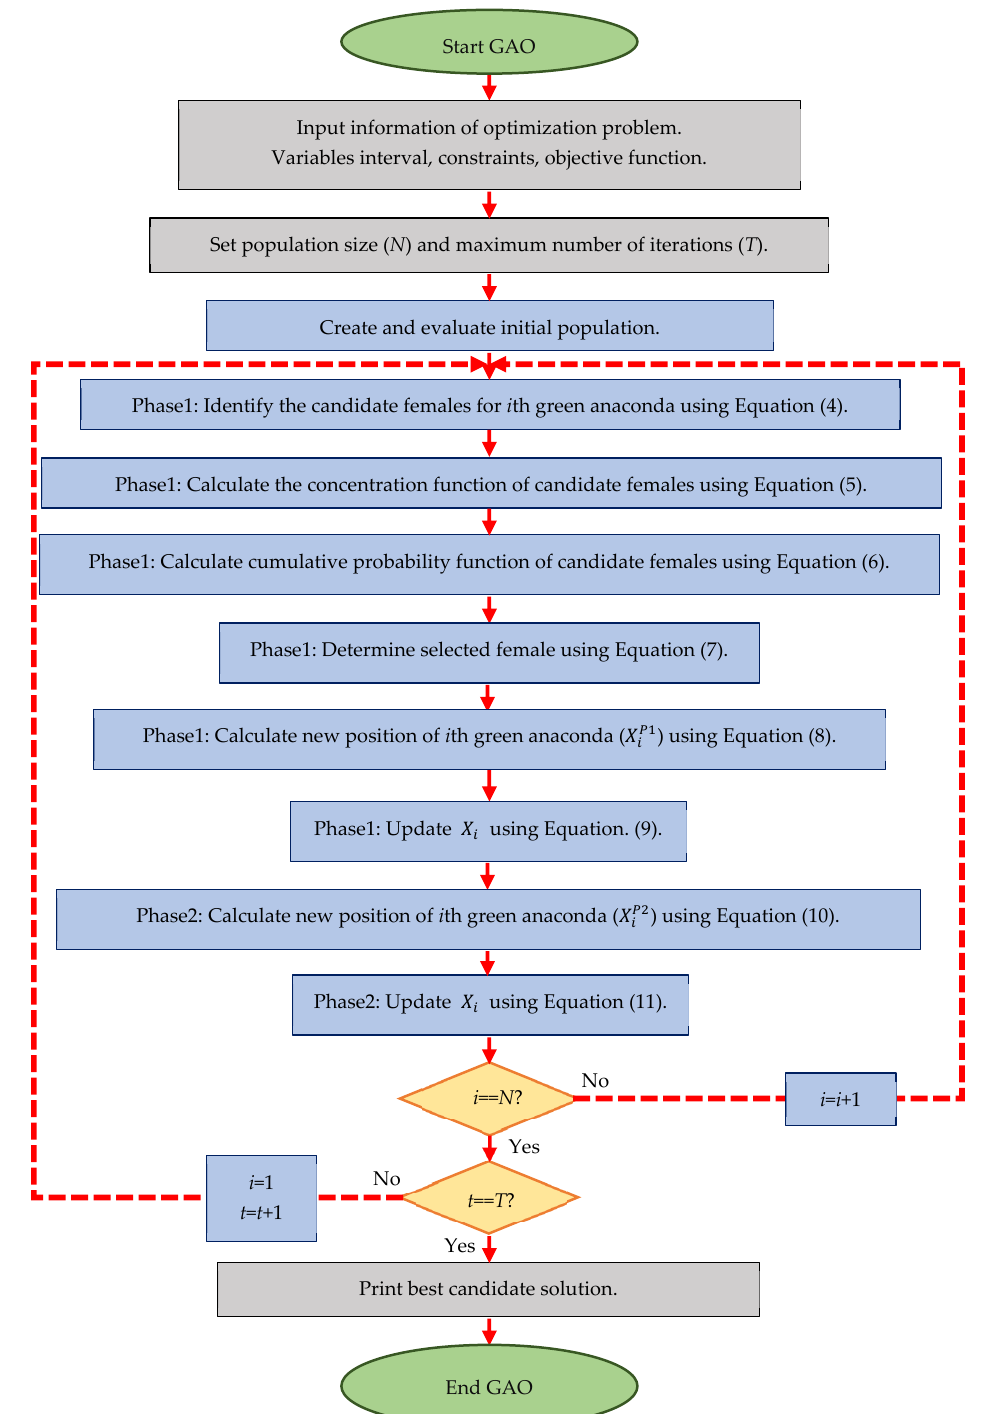
Figure 2. Flowchart of GAO.